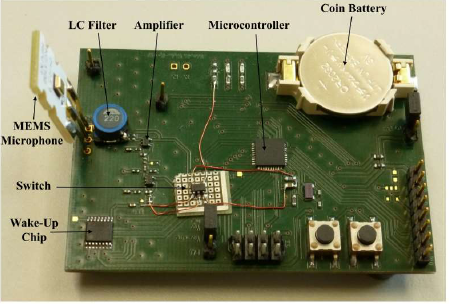
Figure 21. Acoustic wake-up microchip in Architecture 3 [70].